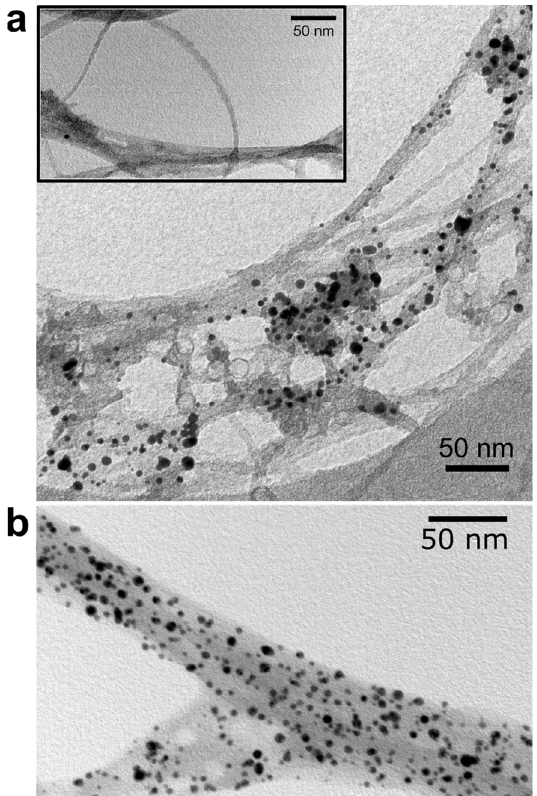
Figure 7. TEM images of Au-functionalized SWNTs with different solvents used during the silanization step: ( a ) toluene ( b ) DMF. The inset shows the negative control sample. Carbon nanotubes are grown by CVD on the substrate from dilute catalyst to prevent catalyst residue from covering the surface (Figure S2a; see supplementary